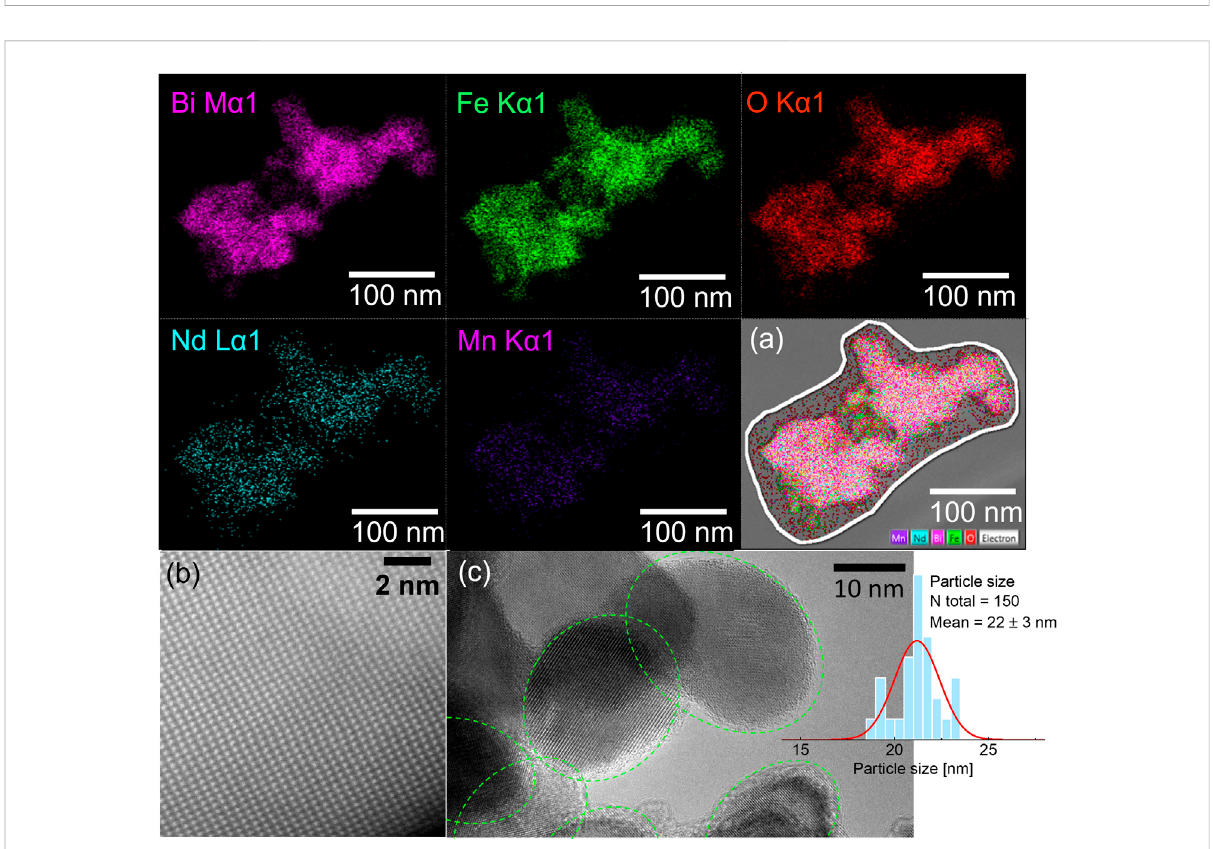
FIGURE 3 Representative HAADF images of the elemental distribution in Nd and Mn co-doped BFO NPs shown by different colors. The overlay of elementsinachosenareaofagglomeratedNPs (A) ,STEMimageofBi-atom ’ sarrangementintheNPs,showshighcrystallinity (B) ,andHRTEMimage along with particle size distribution histogram for Nd and Mn co-doped BFO NPs (C) .